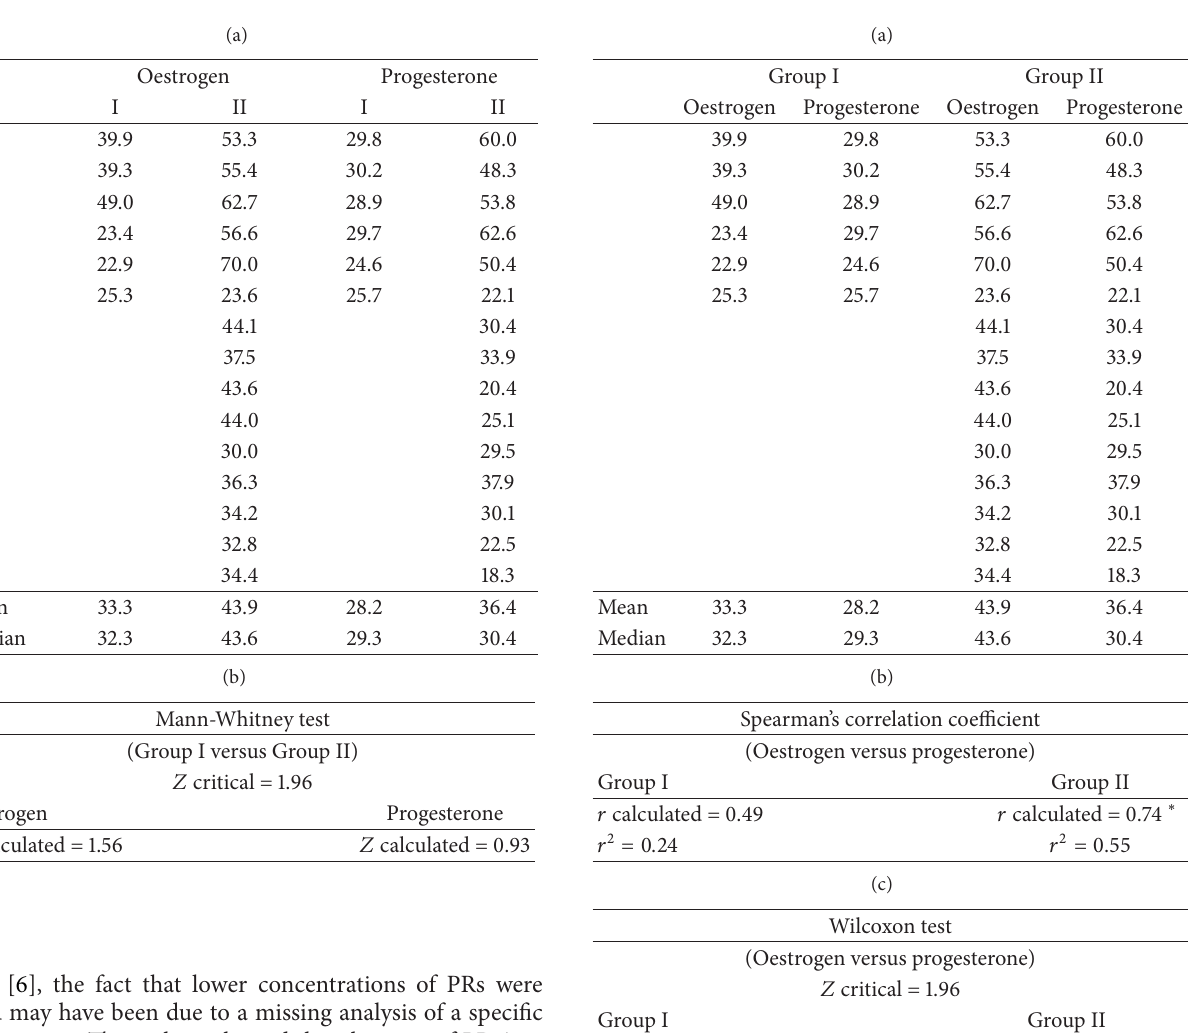
Table 1: Full-term pregnant women in labour (Group I) and full-term pregnant women without labour (Group II) and their concentrationsofmyometrialoestrogenandprogesteronereceptors.